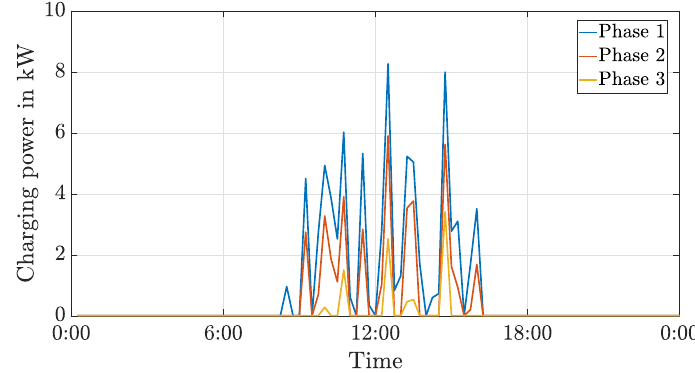
Figure 14. Charging power of the battery system per